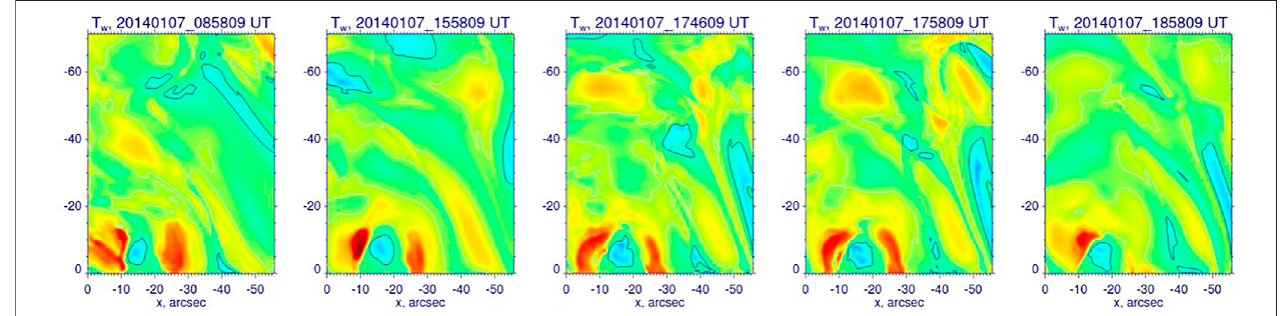
FIGURE6| Fieldlinetwist,T W ,mapsshownforseveralinstancesfortheeast fl uxrope(FR).The T W wascalculatedonaverticalplaneorthogonaltotheeasternPIL. The images are scaled between − 2 < T W < 2, while contours outline areas with | T W | > 1. The x -axis begins at the upper-left end of the cross-section (Figure 1) and the sunspot is outside the FOV on the right side of the panels. The y -axis represents the height above the photosphere in